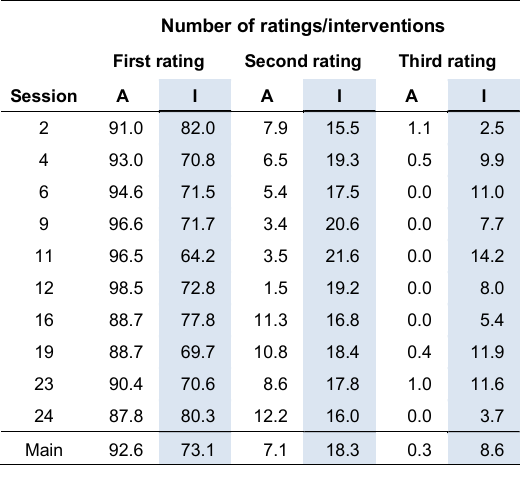
Table 7: Percentage distribution of the number of assessor codings for each therapist intervention, at first, second and third